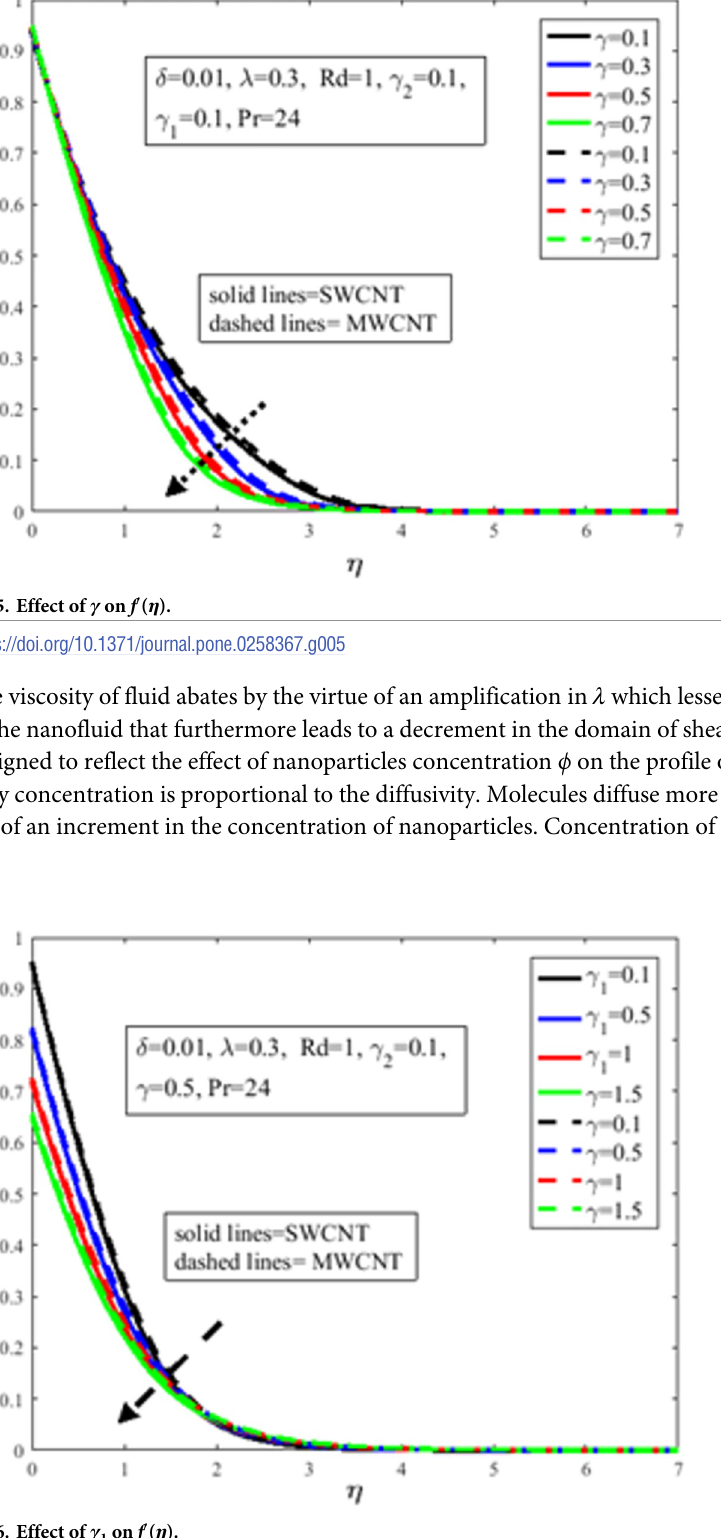
Fig 6. Effect of γ 1 on f 0 ( η